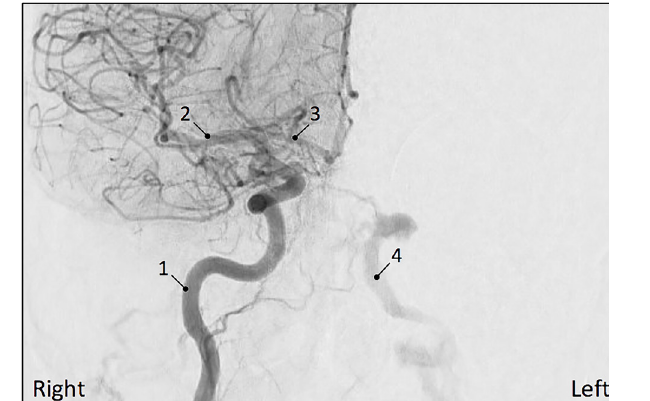
Image 2. Right carotid system angiogram revealing cross-filling into the left carotid system and left inferior petrosal sinus fistula. (1) Right internal carotid artery; (2) middle cerebral artery; (3) anterior cerebral artery; (4) left internal carotid